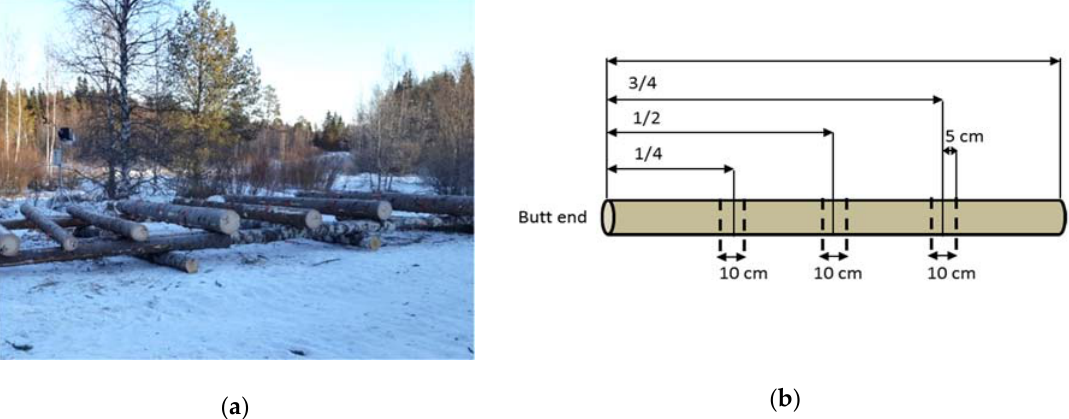
Figure 1. ( a ) The setup for the saw log storage study. The image was taken at the beginning of the winter study. ( b ) Figure indicating the location of the three sample discs cut from each sample log.